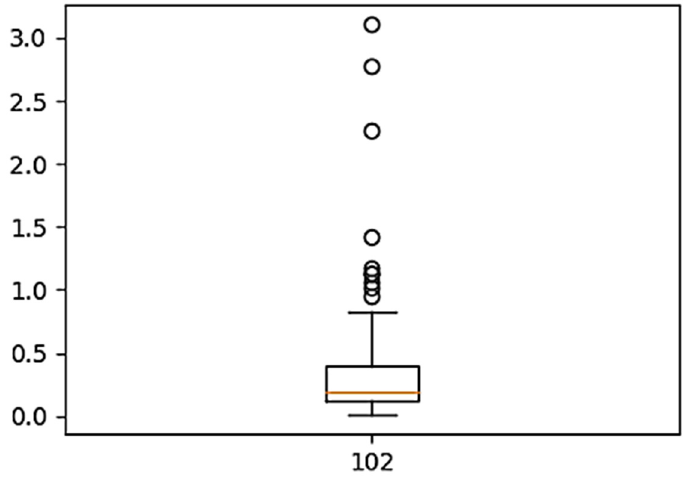
Figure 2. Box diagram of the distribution of Chl- a values in selected analyzed samples.